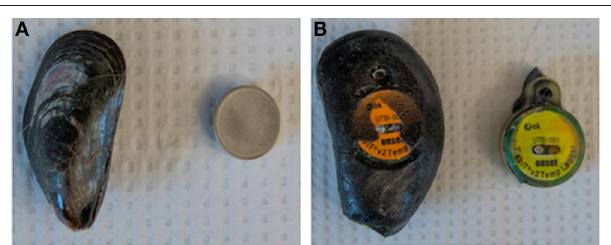
FIGURE 3 | (A) An iButton temperature logger (Maxim Integrated) next to a real Mytilus edulis mussel shell. This biomimic is made by filling the shell with silicone and embedding the logger within. (B) An unmodified HOBO TidbiT v2 temperature logger (Onset Computer Corporation) next to a biomimic. The biomimic is a custom cast made of Evercoat Premium Marine Resin modeled after a larger (74mm) mussel (Fitzhenry et al., 2004), more suitable for use approximating body temperatures of the larger M. californianus species from the Pacific